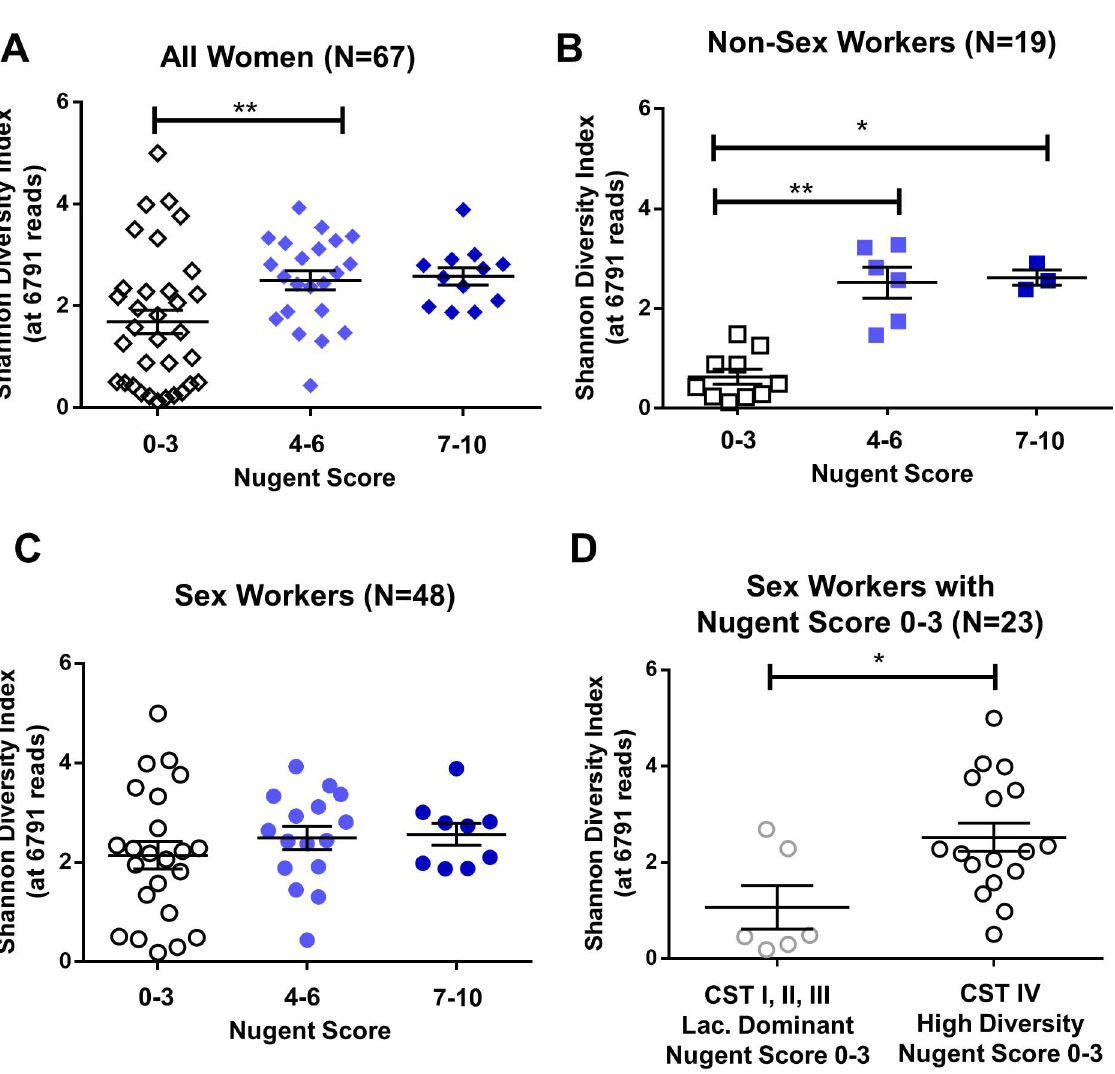
Fig 6. Diversity of the vaginal microbiota may not be linked to Nugent Score in FSW. There was significantly greater bacterial diversity (P = 0.0067) in the women with Nugent Scores of 4–6 as comparedto those with Nugent Scores of 0–3 when the relationship between diversity and Nugent Score was examinedincludingall 67 women (Non-SexWorkers (NSW) and Female Sex Workers (FSW)) (A). When only NSW (N = 19) were includedin the analysis, similar relationshipswere found, where Shannon Diversity was significantly greater in NSW with Nugent Score of 4–6 and 7–10 versus those with scores of 0–3 (P = < 0.0001)(B). However, when only FSW were includedin the analysis(N = 48) there were no significantdifferences in the ShannonDiversity Index (6791 reads) betweenFSW with Nugent Scores of 0–3, 4–6, or 7–10 (P = 0.5051) (C). When FSW were stratified by community state type (CST) ( Lactobacillus dominantvs. high diversity), the majority of the FSW with Nugent Scores 0–3 were in CSTIV and had significantly greater bacterial (17/23) diversity than FSW in CSTI, II, and III who also had Nugent Scores of 0–3 (6/ 23) (P = 0.0348)(D). BV: bacterialvaginosis,CST: community state type. * : P < 0.05, ** : P < 0.01. Data is presentedas mean ±